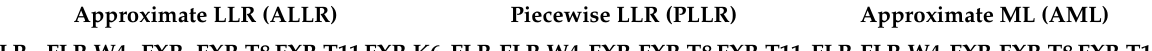
Table 1. Resources of our 64-QAM circuits on Xilinx Zynq Ultrascale + ZCU106 (230 K LUTs, 461 K DFFs) w/o